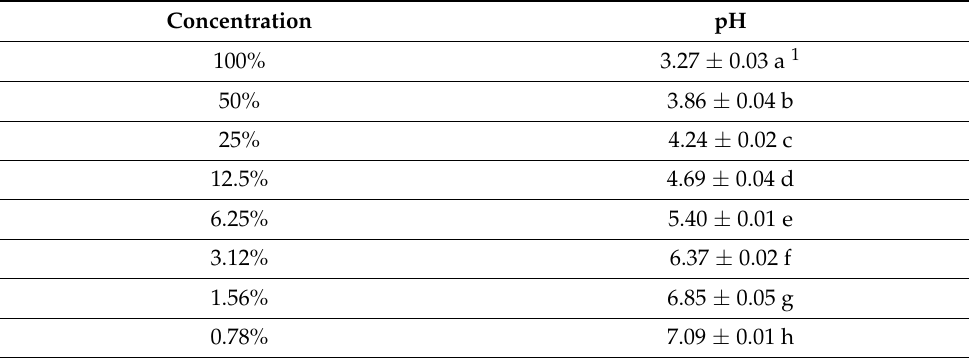
Table 2. The pH values of diluted ohelo berry